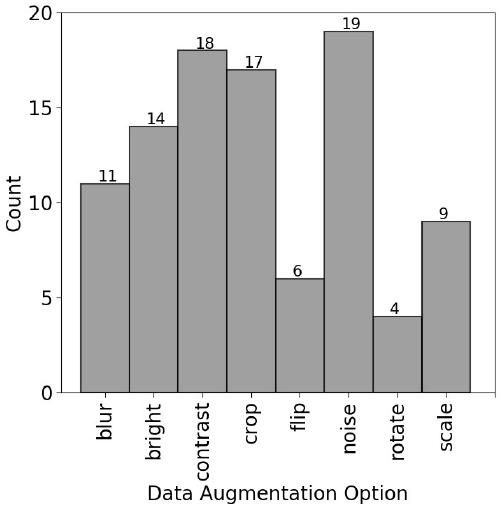
Figure 6. Frequency of each data augmentation option used in trained models reaching maximum pIOU in test datasets acquired on different dates (the last column in Table